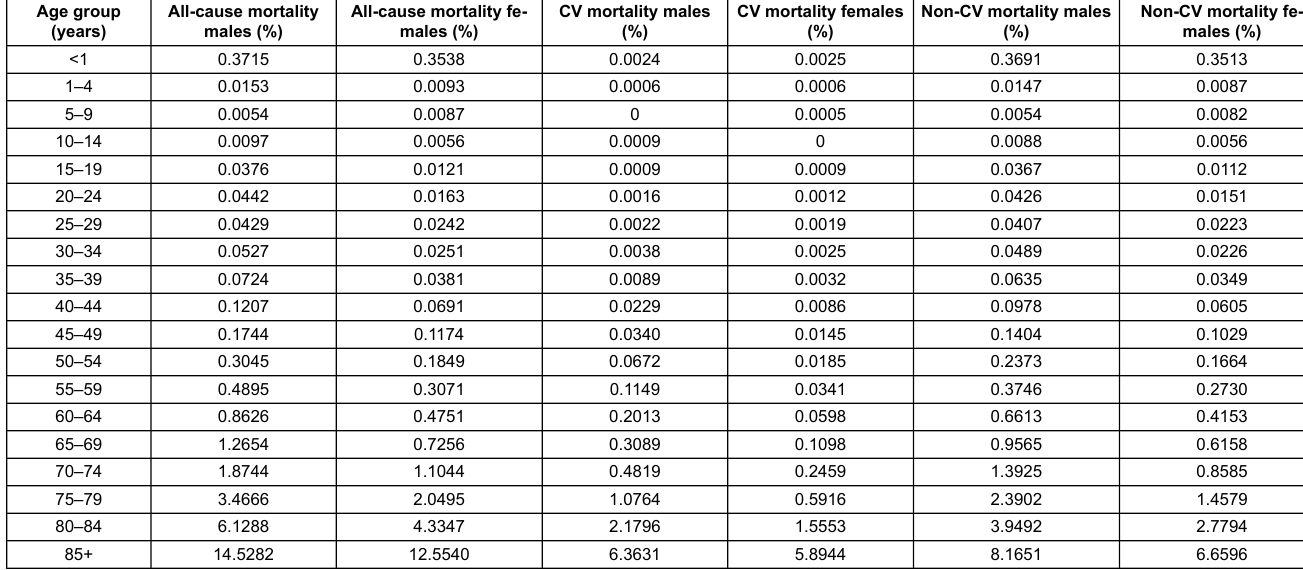
Table S6: Non-cardiovascular mortality of the Swiss population in 2012. Age group